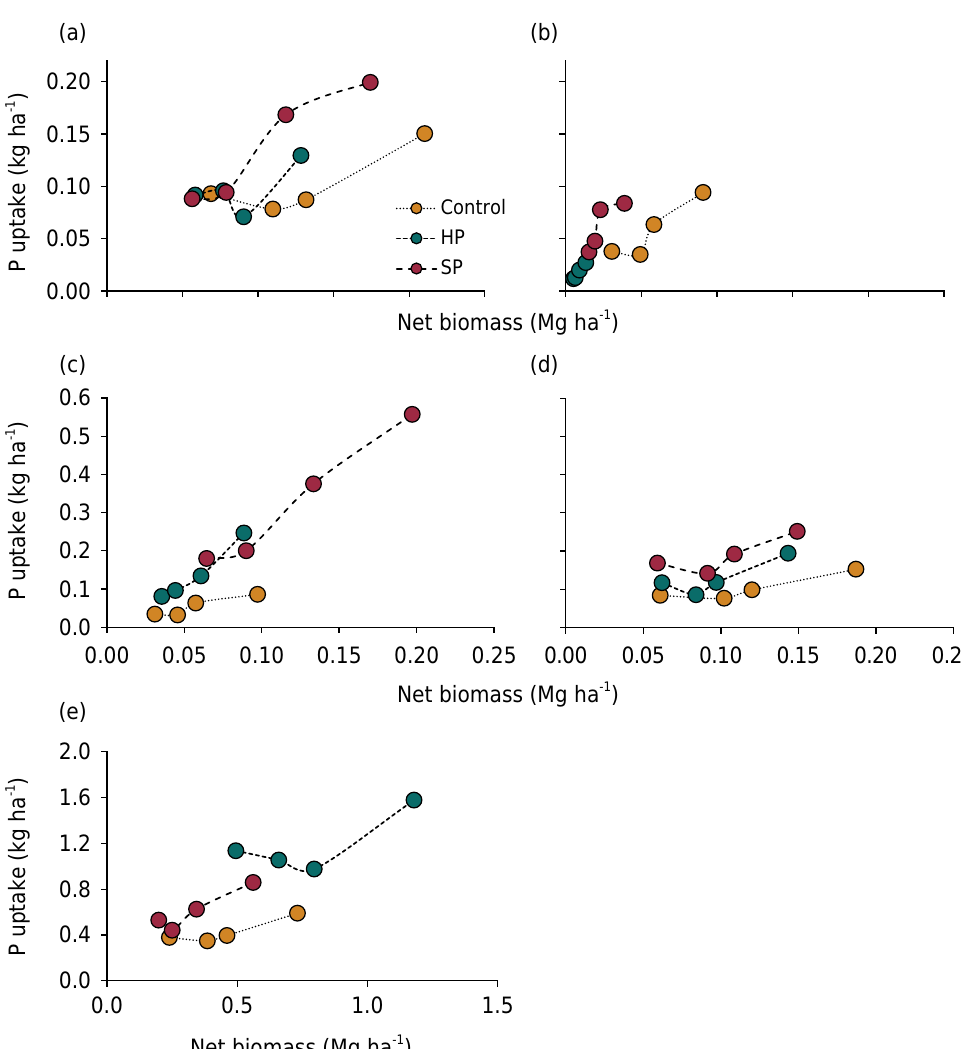
Figure 5. Relationship between P uptake and accumulated dry matter for different native species (a) Aristida laevis , (b) Dichantelium sabulorum , (c) Eusthachys uliginosa , (d) Paspalum plicatulum and (e) Paspalum notatum of a natural grassland from Southern Brazil with application of different P sources Control: without P addition; HP: hyperphosphate; SP: superphosphate.